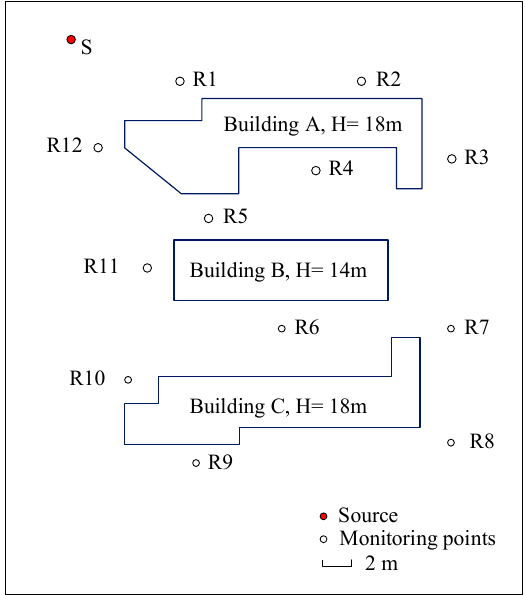
Figure 3. Sketch of the experiment.